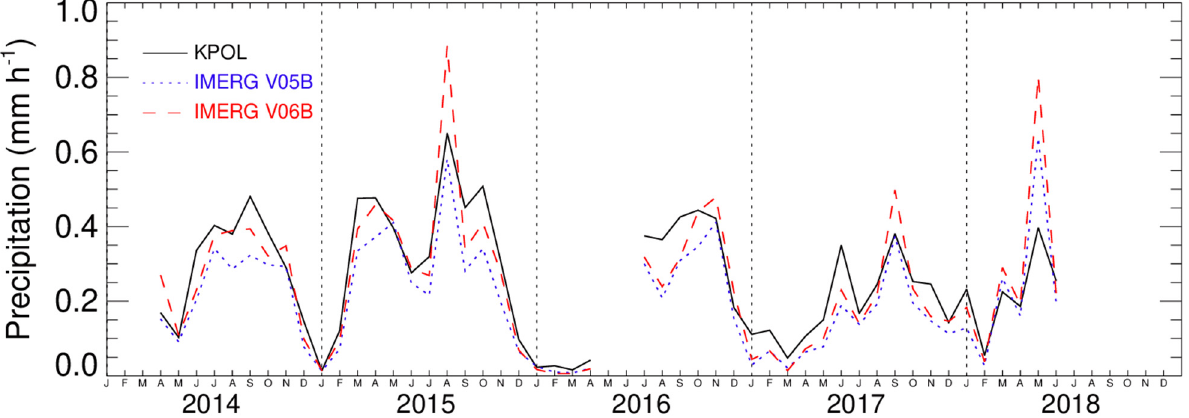
Figure 2. Monthly precipitation rates averaged over the 100-km range from the half-hourly precipitation rates at 0.1° resolution from KPOL, IMERG V05B and V06B.